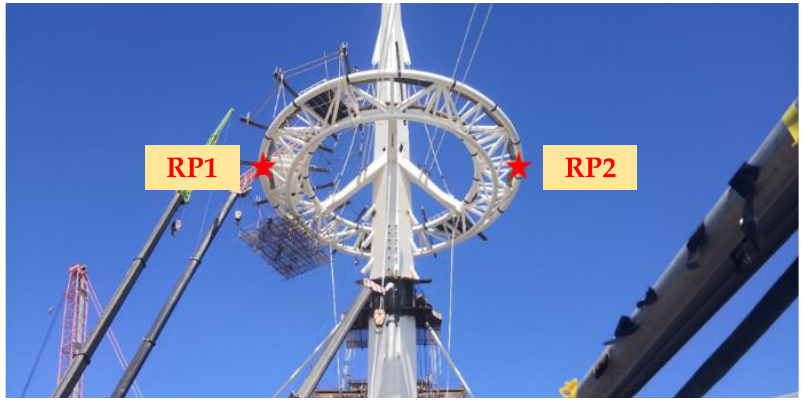
Figure 19. Layout of monitoring points. Two FE models considering the RCS of the UHS (the rotational restraint stiffness calculated from Equation (15)) and without considering the RCS of the UHS (the rotational stiffness is zero) are established, respectively, both of them include the entire construction process. The influence of the RCS on the attitude of the bridge tower in each construction stage is analyzed. The same tension is applied to the two models, respectively, and the bridge tower states at each construction stage are obtained. A comparison of the rotation angle of the bridge tower in each construction stage of the two models is shown in Figure